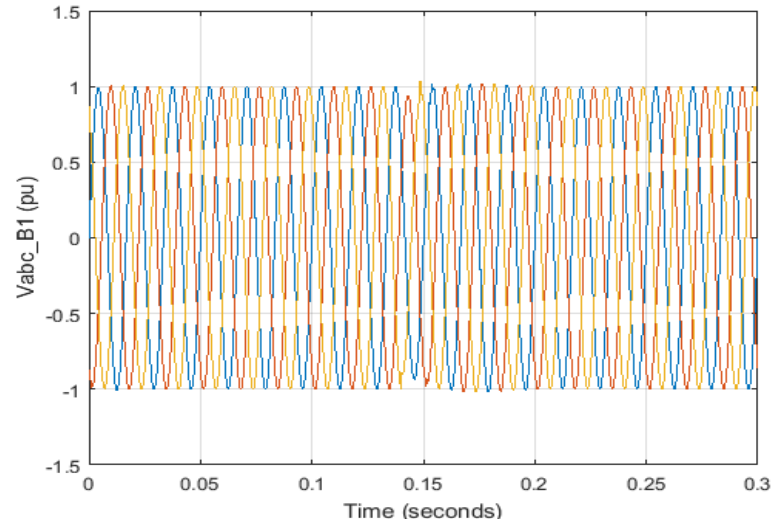
Figure 13. Grid and microgrid voltage common point.